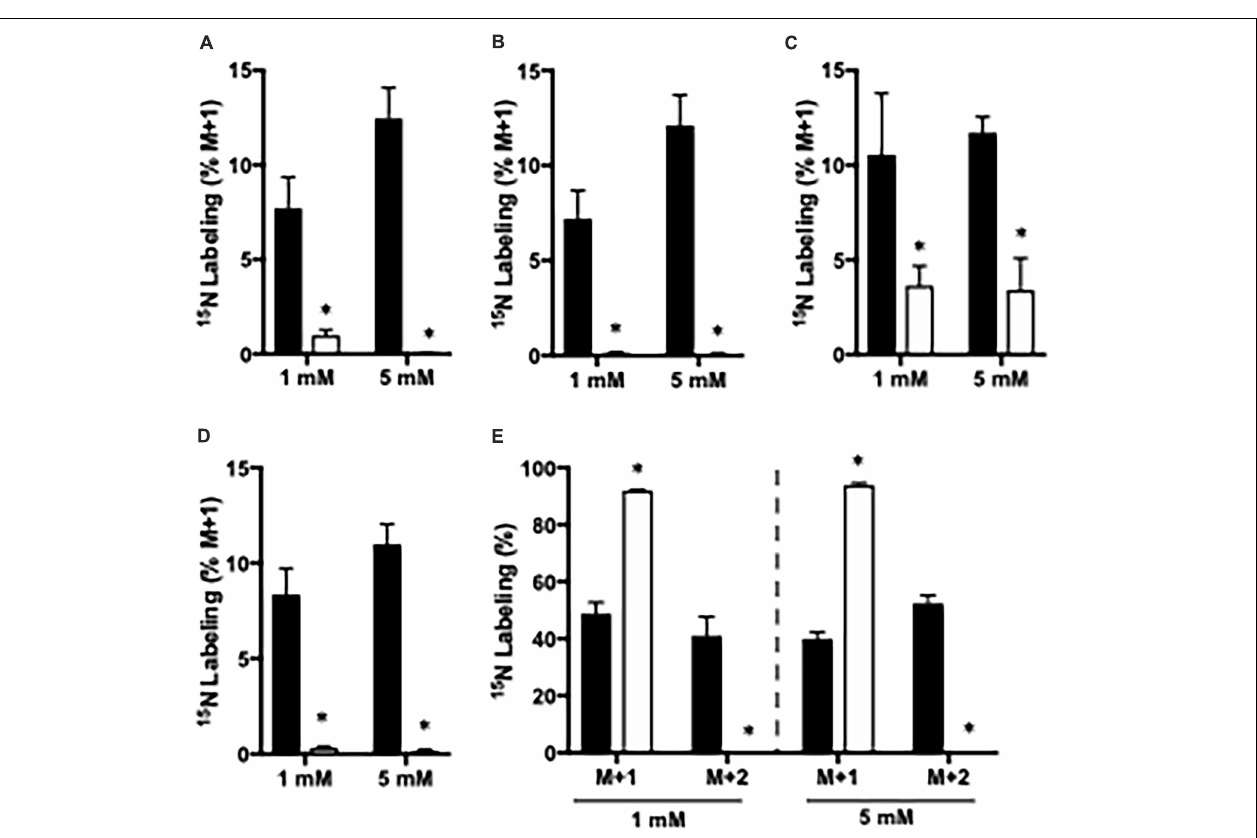
FIGURE 2 | The percent 15 N labeling in metabolites in cortical slices from Glud1 lox / lox (filled bars) and CNS- Glud1 − / − mice (open bars) mice following incubation in the presence of 1 or 5 mM 15 NH 4 Cl for 60 min as detailed in Materials and methods. The percent mono-labeled glutamate (A) , aspartate (B) , alanine (C) , GABA (D) as well as the percent of glutamine being mono- or double labeled (E) was determined from GC-MS analysis of slice extracts as detailed in Materials and methods. Results are averages ± SEM ( n = 5–8), and the asterisk indicates a statistically significant difference between Glud1 lox / lox and CNS- Glud1 − / − mice ( P < 0.05).